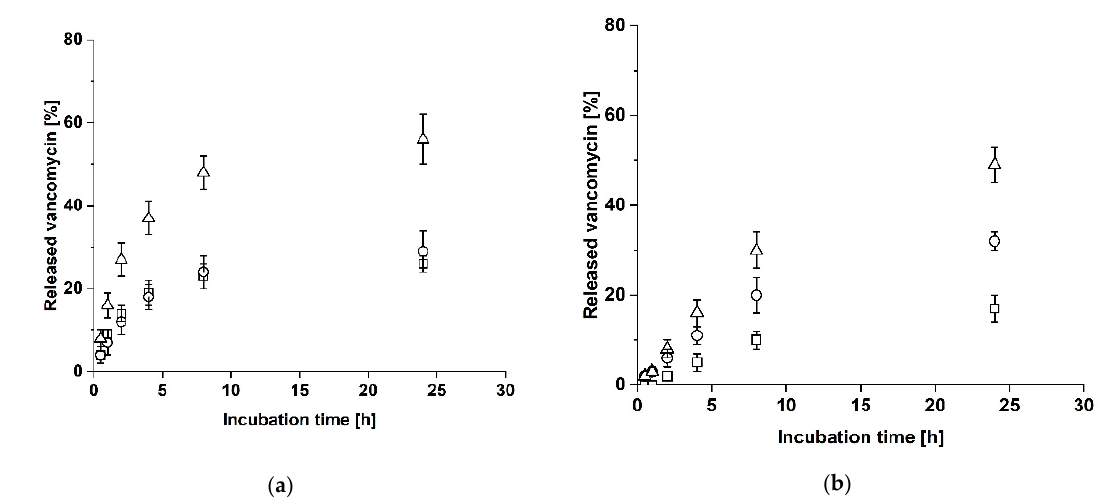
Figure 6. Release of vancomycin from symmetrical three-layer laminates. The release in the upper cavity (squares), the lower cavity (dots) and in total (triangles) was analyzed. The error bars represent the standard deviation ( n = 3). ( a ) Atelocollagen loaded with vancomycin between two sheets of Collagen Solutions (laminate CAC). ( b ) Atelocollagen loaded with vancomycin between two sheets of Atelocollagen (laminate AAA).